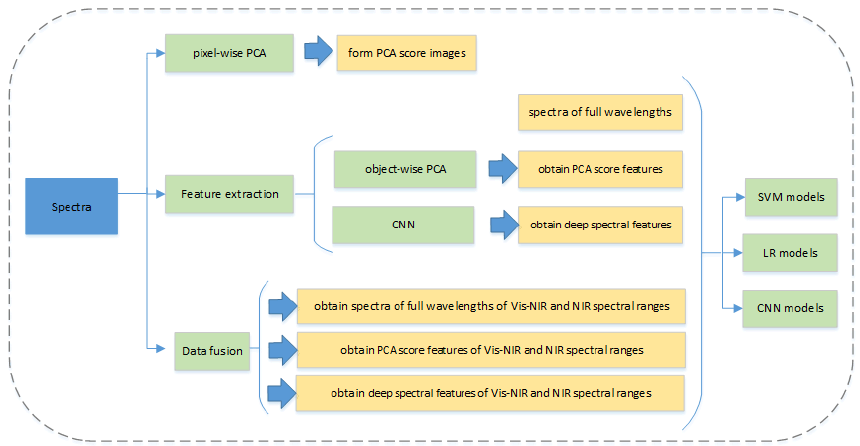
Figure 4. The flow chart of the analysis process in this study.